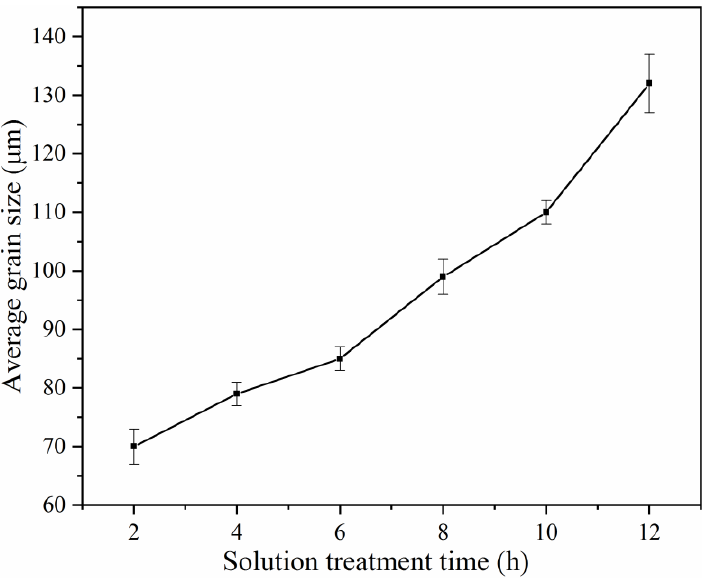
Figure 2. The average grain size of solution-treated alloy with different solution treatment time.